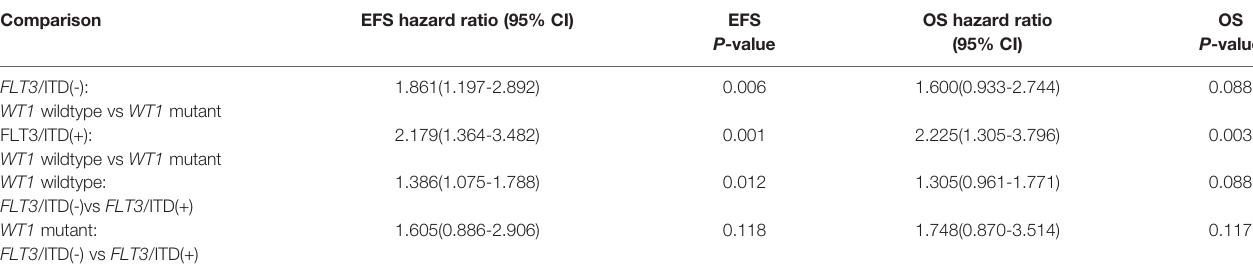
TABLE 2 | Statistical comparison of survival data according to both WT1 and FLT3 /ITD status.